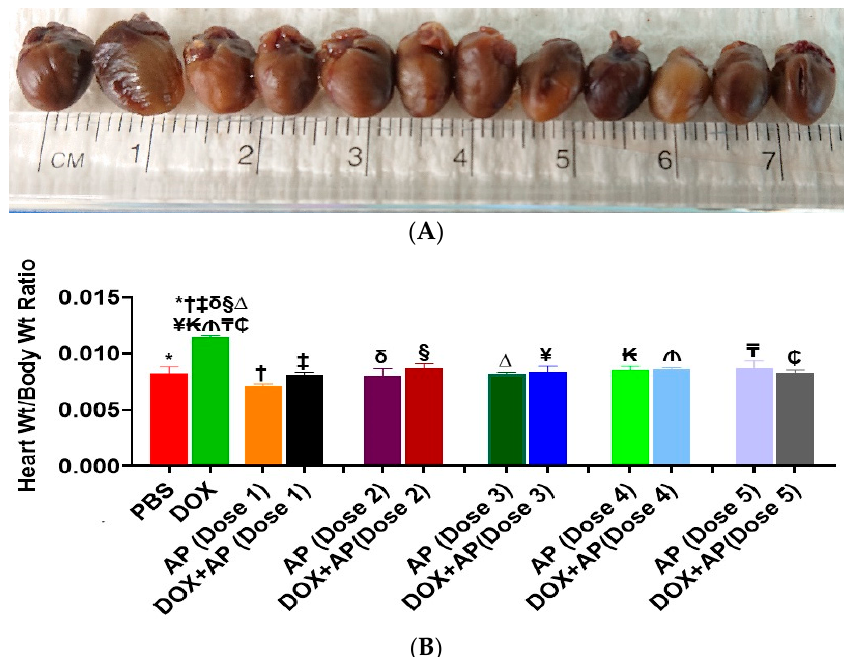
Figure 2. Substance P receptor antagonism significantly attenuates doxorubicin-induced increases in heart size and heart-to-body weight ratios. ( A ) Effect of SP receptor antagonism on doxorubicin induced increases in heart size. Gross appearance of a representative heart derived from mice treated with the following, order from left to right; Sham, DOX alone, Dose1 of aprepitant (AP) without DOX, DOX + Dose 1 (AP), Dose 2 (AP) without DOX, DOX + Dose 2 (AP) Dose 3 (AP) without DOX, DOX + Dose 3 (AP), Dose4 (AP) without DOX, DOX + Dose 4 (AP), Dose 5 (AP) without DOX, or DOX + Dose 5 (AP).( B ) Effect of SP receptor antagonism on DOX induced increases in Heart Weight to body weight ratios (Hw/Bw). Heart weight to body weight ratio was significantly increased in the DOX treated group compared to the vehicle treated group (*, p < 0.05, ANOVA, Tukey’s test). Importantly, compared to treatment with DOX alone, treatment with all 5 doses of aprepitant (a SP receptor antagonist, Merck & Co.) resulted in significant reduction of the Hw/Bw ratios ( * , PBS vs. DOX; † , AP (Dose1) vs. DOX; ‡ , DOX + AP (Dose 1) vs. DOX; δ , AP (Dose 2) vs. DOX; § , DOX + AP (Dose 2) vs. DOX; ∆ , AP (Dose 3) vs. DOX; ¥ , DOX + AP (Dose 3) vs. DOX; K , AP (Dose 4) vs.